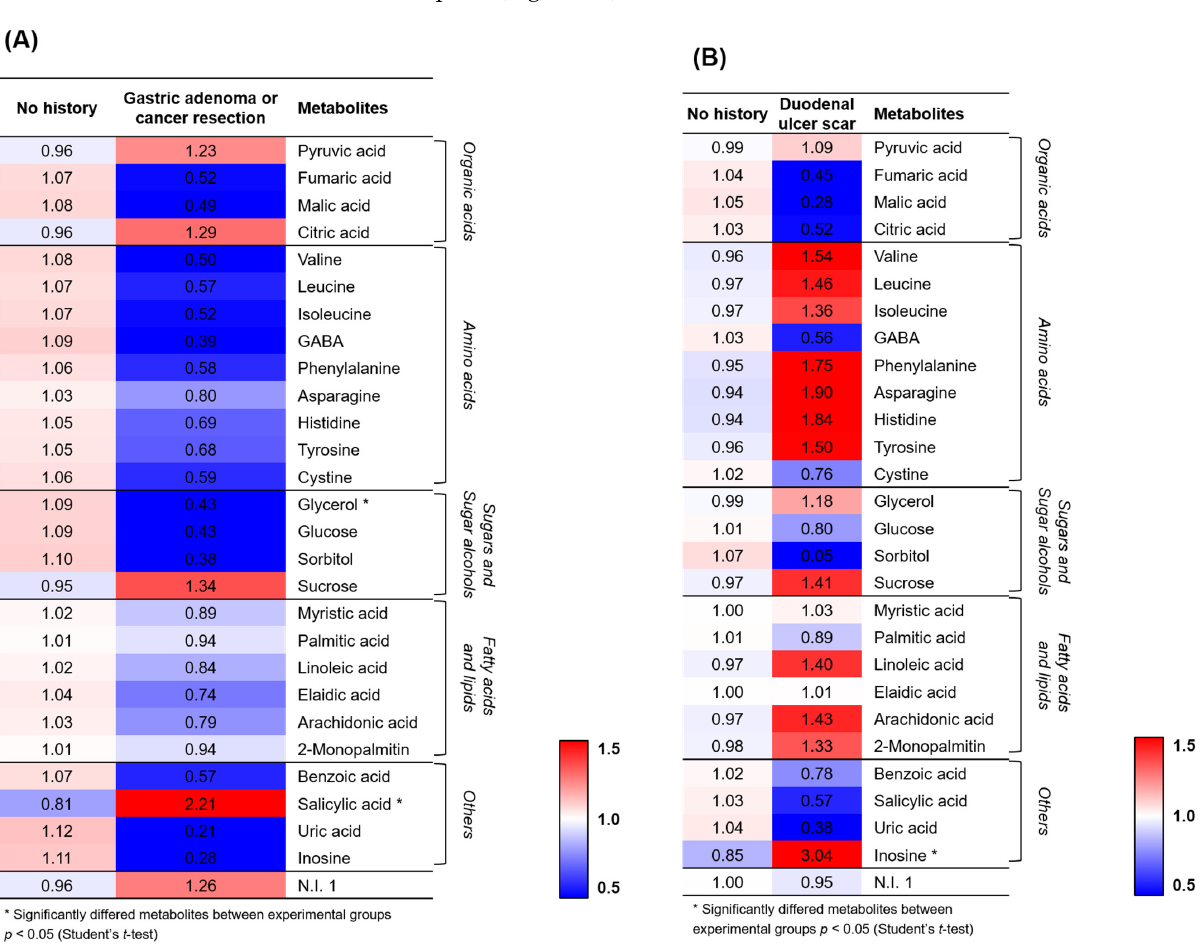
Figure 2. ( A ) Heat map analysis for the relative abundance of different metabolites (VIP > 1.0) derived from the GC-TOF-MS analysis for the comparison between 26 patients without a history of gastric neoplasm and 4 patients with a history of gastric adenoma or cancer resection. ( B ) Heat map analysis for the comparison between 28 patients without duodenal ulcer scars and two patients with duodenal ulcer scars. The colored squares (blue to red) indicate the fold changes normalized by the average of each metabolite. * Significantly different metabolites among the two groups; p < 0.05 using the Student’s t